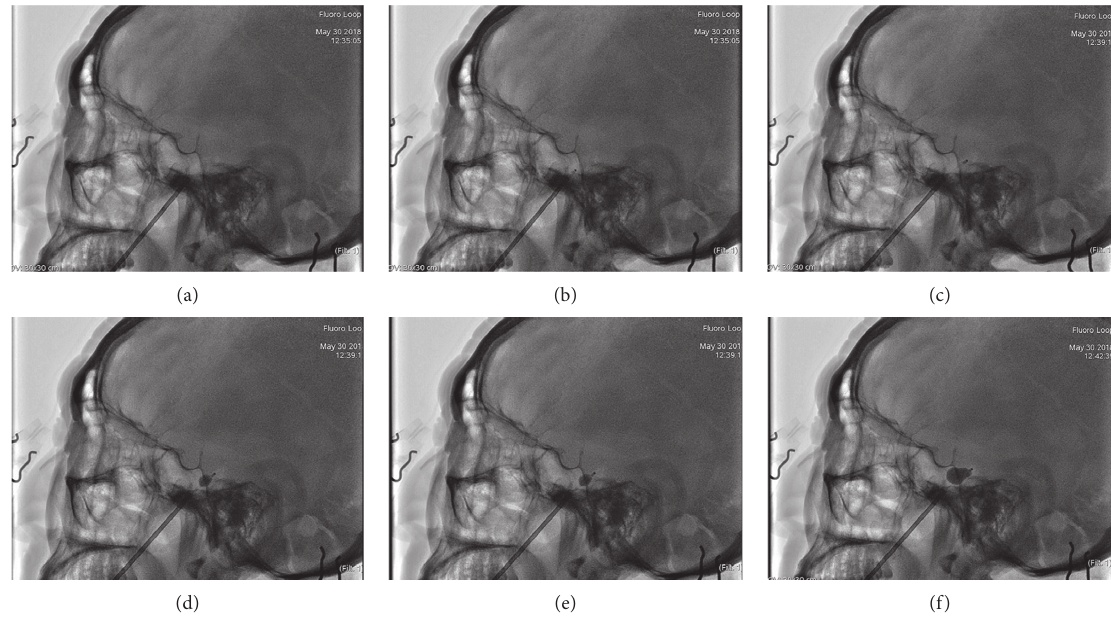
Figure 2: C-arm-guided FO puncture. (a) The needle penetrated the foramen ovale under lateral C-arm imaging; (b), (c) the balloon catheter was advanced into Meckel’s cave under direct C-arm fluoroscopy; (d, e) the balloon was slowly inflated with nonionic contrast agent (omnipaque) under fluoroscopic monitoring; (f) the shape of the balloon was confirmed to be pear-like on lateral C-arm